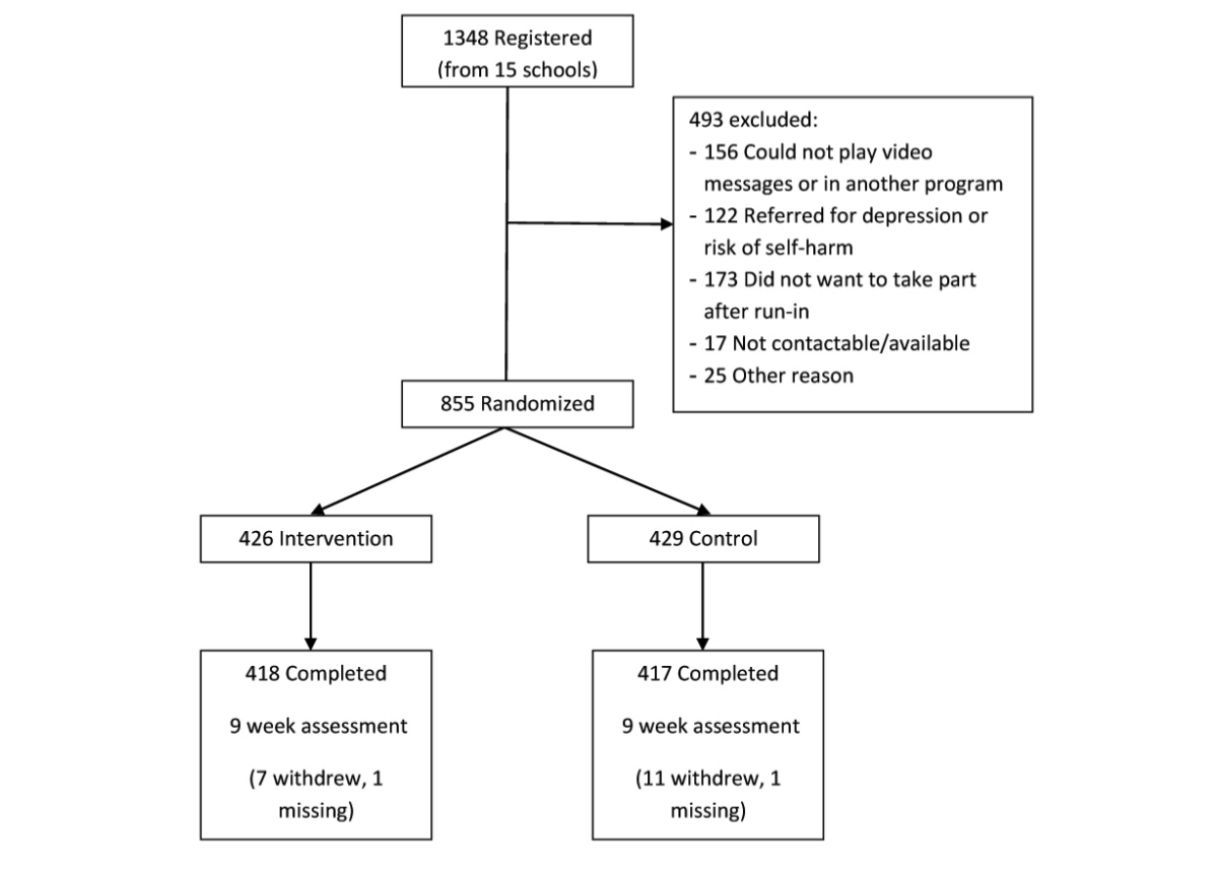
Figure 1. CONSORT flowchart of participants in the MEMO trial.